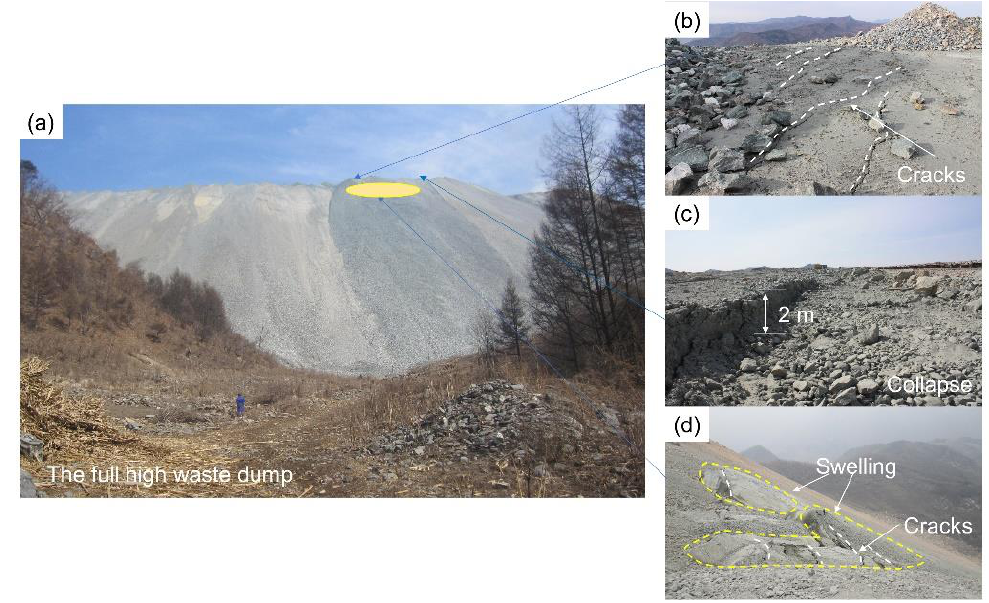
Figure 3. Cracks and collapse: ( a ) the full high waste dump; ( b ) cracks; ( c ) collapse; ( d ) swelling and cracks. Water 2020 , 12 , x FOR PEER REVIEW